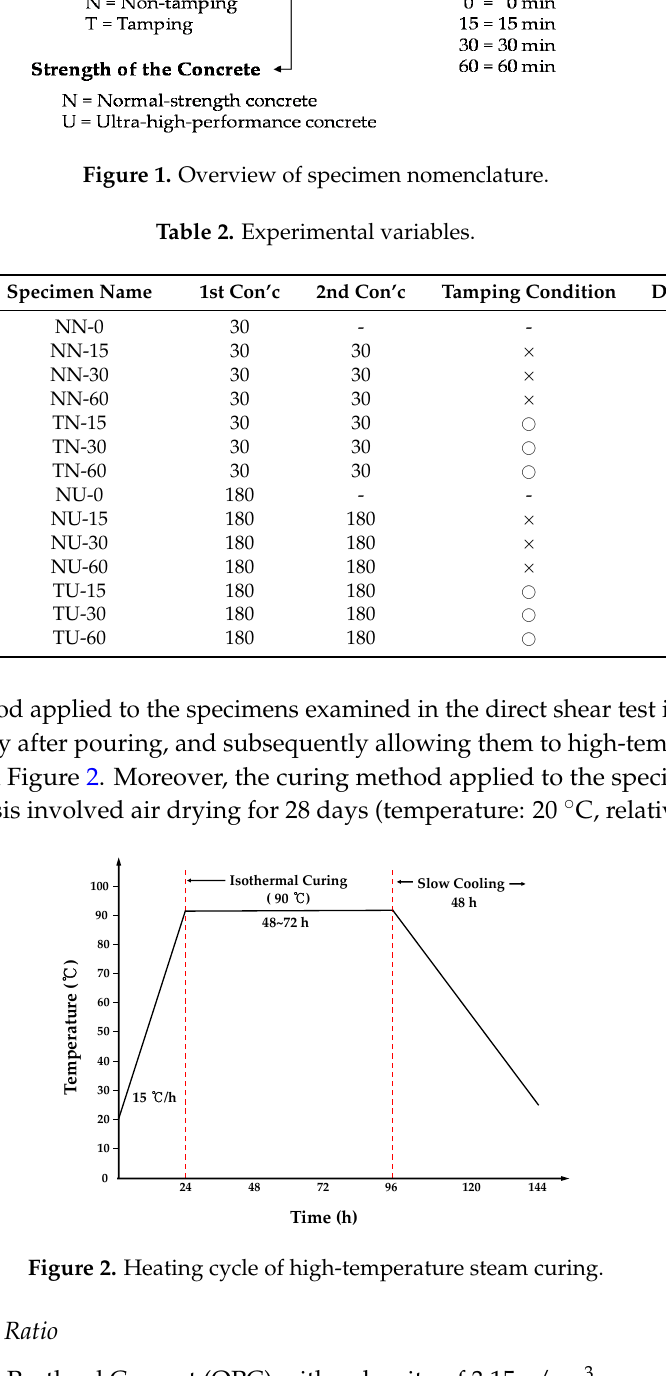
Figure 2. Heating cycle of high-temperature steam curing.